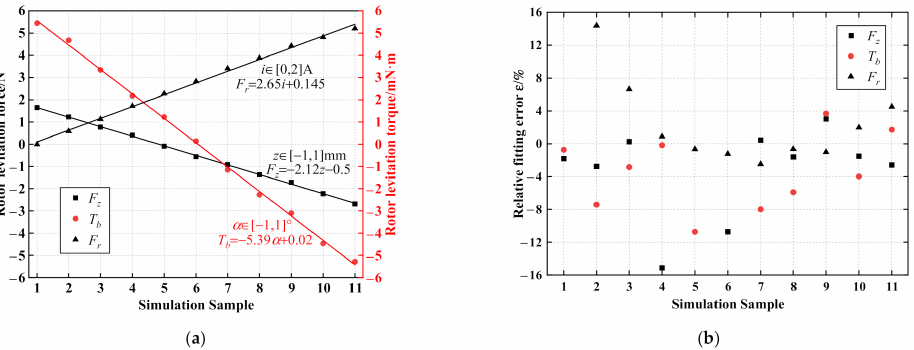
Figure 3. Linear fitting of BPMSM performance. ( a ) Linear fitting of axial levitation force, tilting levitation torque, and radial levitation force; and ( b ) relative fitting error of F z , T b , and F r